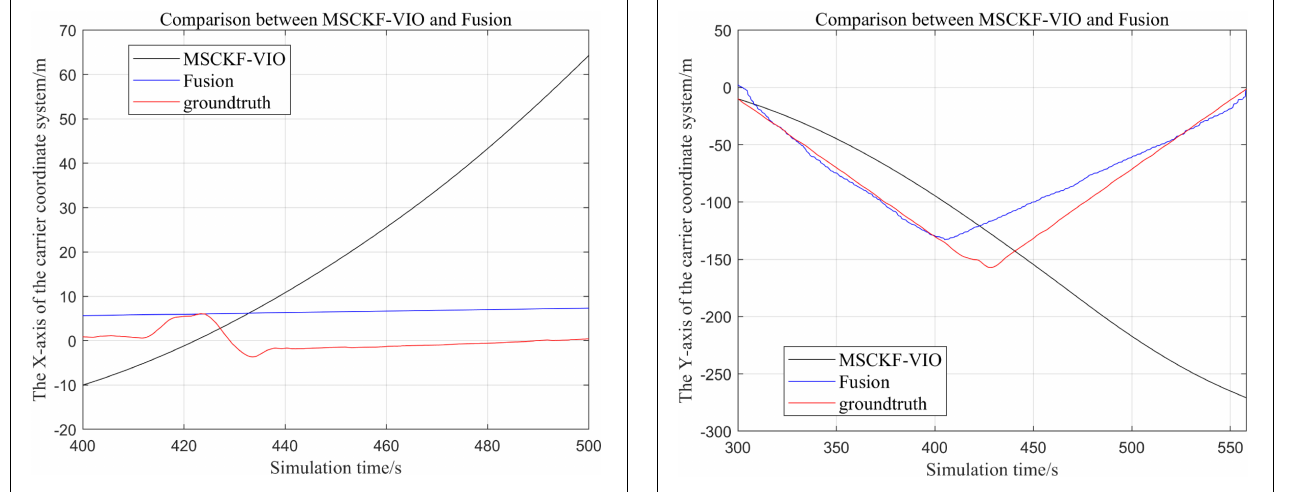
FIGURE 5 | Comparison of the fusion algorithm with the MSCKF_VIO algorithm for zooming in on the x -axis local trajectory.